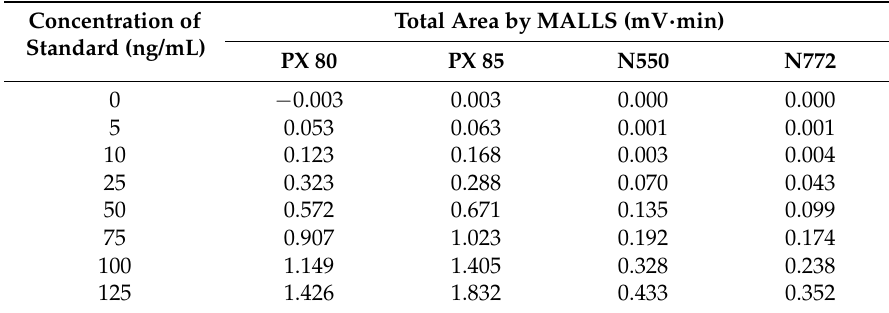
Figure 4. Sum of all MALLS detector angle areas (total area) versus concentration of PX 80 (1 mL injections). Table 4. Total peak areas of the respective CB standards used for the calibration.